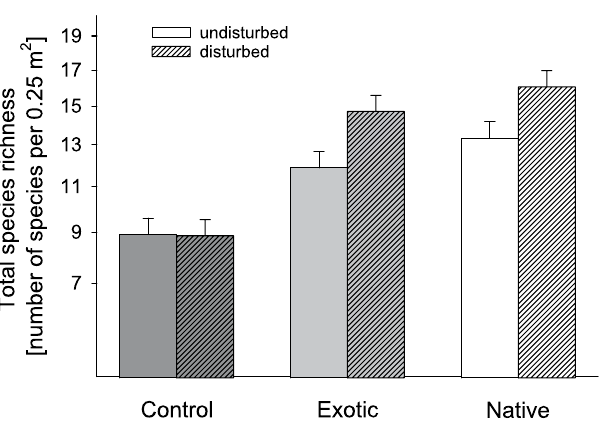
Figure 3. Effect of seed addition (control = no seed addition, exotic = exotic seed addition, native = native seed addition) and disturbance (undisturbed, disturbed) on total species richness (including resident and sown species). Data shown are least square means of repeated-measure linear mixed models ± SE averaged across two years. Note that species richness is given on a square root